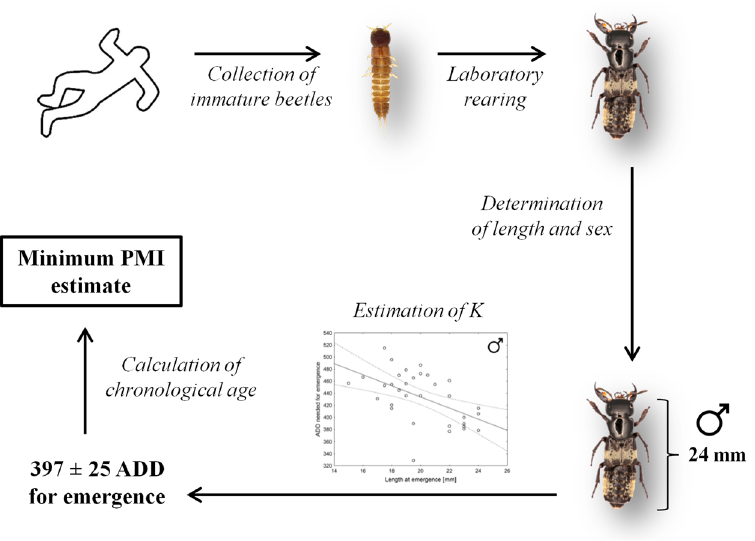
Figure 6. A schematic representation for the implementation of the method in forensic entomology. Anna Mądra-Bielewicz is the copyright holder of the C. maxillosus pictures used in this